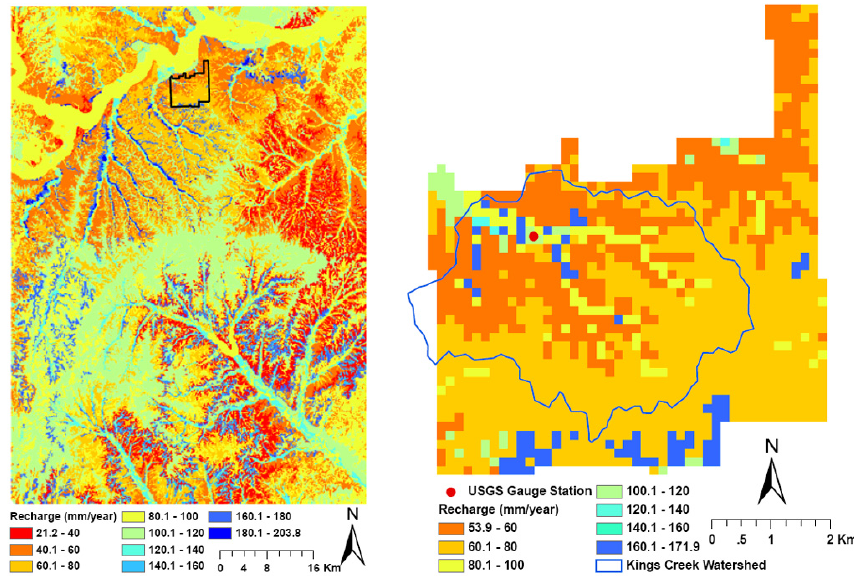
Fig. 5. Spatial distribution of recharge in the study region and at Konza LTER.